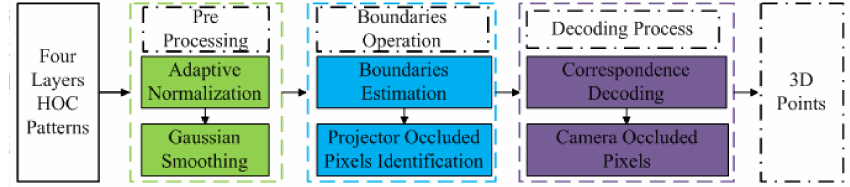
Figure 2. Flow diagram of Boundary Inheritance Codec decoding